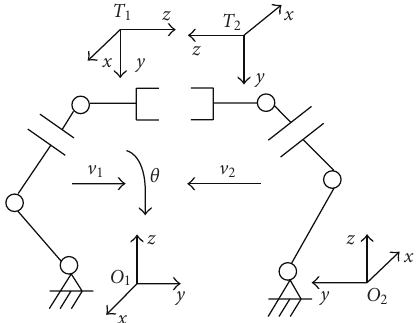
Figure 2: The sketch map for cooperative modular robots. coordinate system origin of its end executor. O 2 represents the base coordinate system origin of the master robot, and T 2 represents the base coordinate system origin of its end executor. θ is the angle vector of T 1 rotating around Z T 2 (